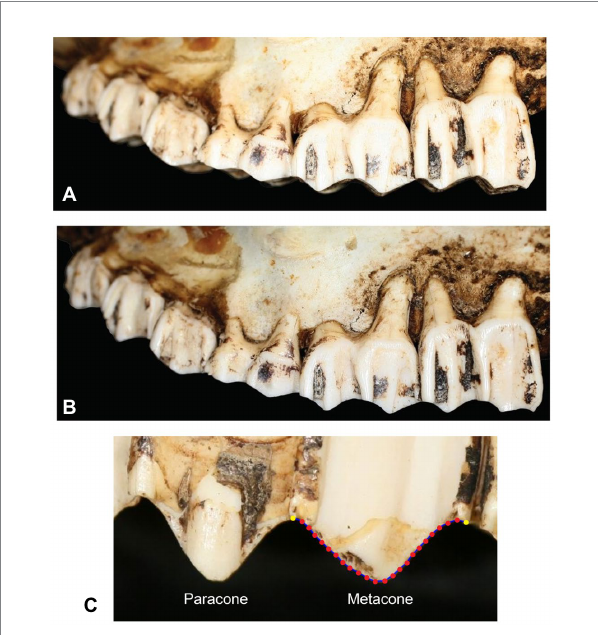
FIGURE 2 Left upper cheek tooth row of Cervus canadensis showing photographic angle. Specimens were oriented so the buccal wall of M2 was perpendicular to the camera lens. (A) When lingual sides of the cheek teeth were visible, (B) the specimen was rotated slightly until the lingual sides were obscured from view, and the photograph was taken. (C) Buccal view of the second upper molar (M2) of a specimen of Syncerus caffer (AMNH 53582) showing the landmarks (yellow) and semilandmarks (red) that were digitized on the occlusal outline of the metacone cusp. Digitization of the occlusal outline starts at the posterior end of the metacone (right side of the image) and ends at the metacone-paracone